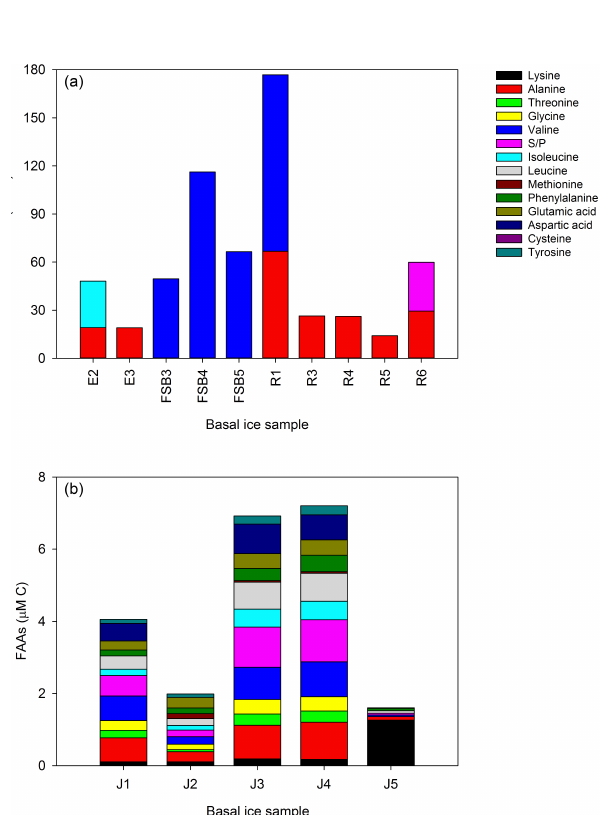
Figure 4. FAA composition in basal ice samples from (a) Engabreen (E), Finsterwalderbreen (F), Russell Glacier (R), and Joyce Glacier (J), (b) FAAs in Joyce Glacier basal ice, plotted sepa- rately due to an order of magnitude increase in concentrations. Sam- ples with zero concentrations have been excluded from the plot, and only values >LOQ have been included. S/P – serine and proline, re- ported together due to co-elution. SB – solid